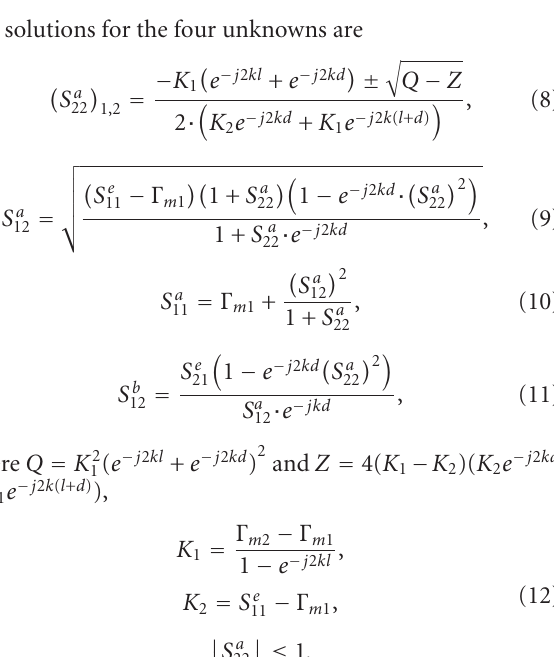
Figure 11: Material parameter measurement error caused by 0.1 mm air gap.